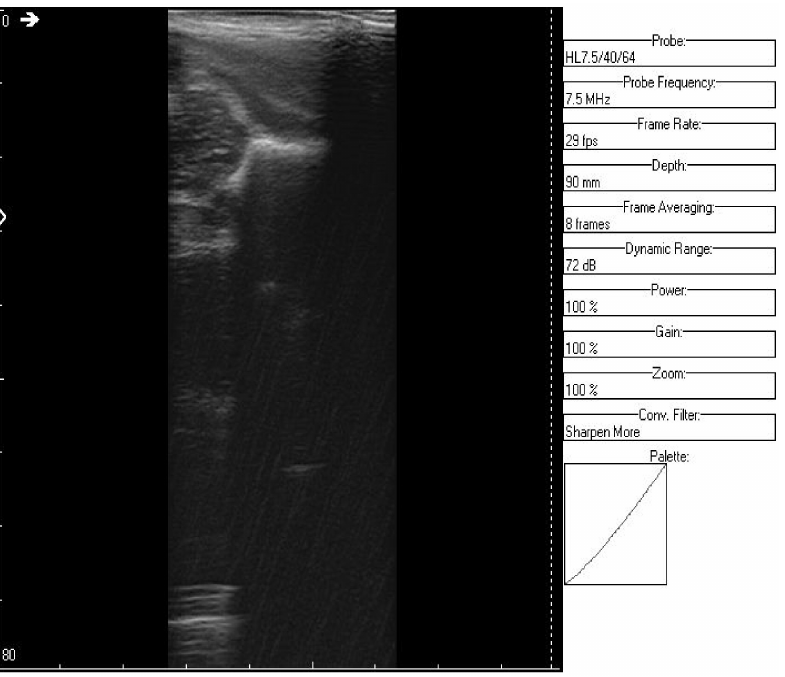
Figure 3. Original recorded